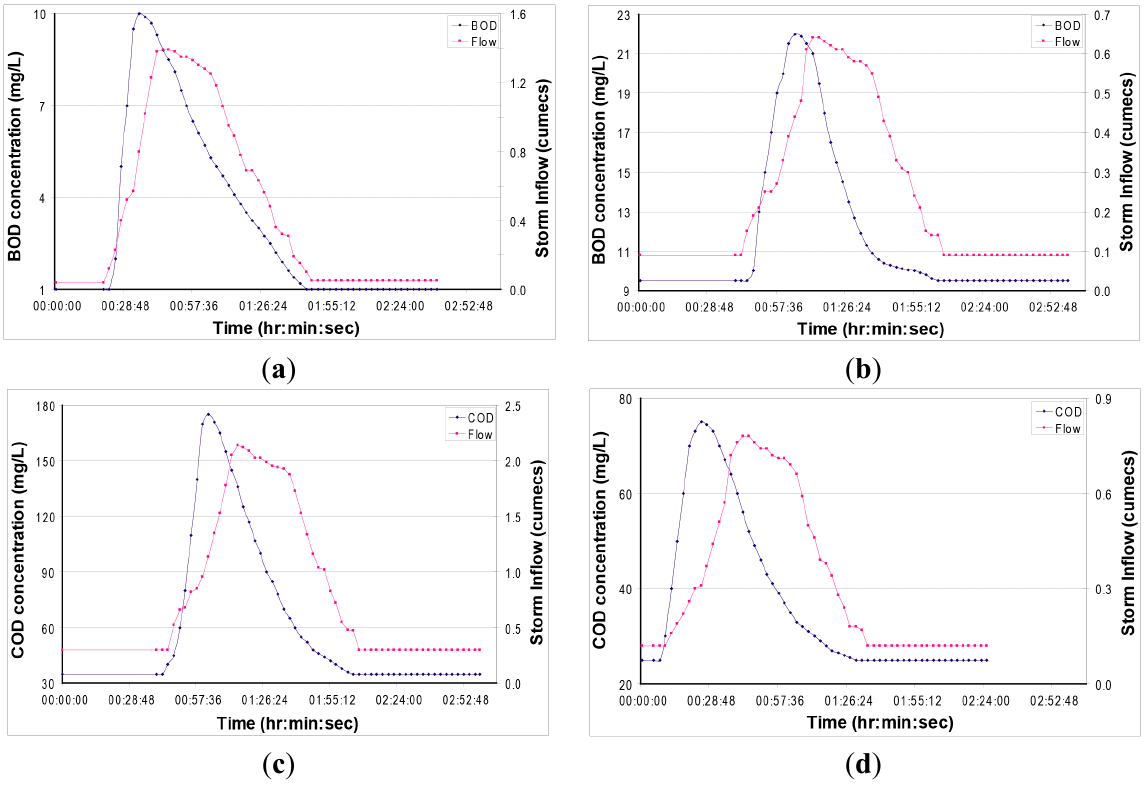
Figure 4. Pollutographs for migrating storms. ( a ) BOD pollutograph for Millers Bridge; ( b ) BOD pollutograph for Sandhills Lane; ( c ) COD pollutograph for Rimrose; ( d ) COD pollutograph for